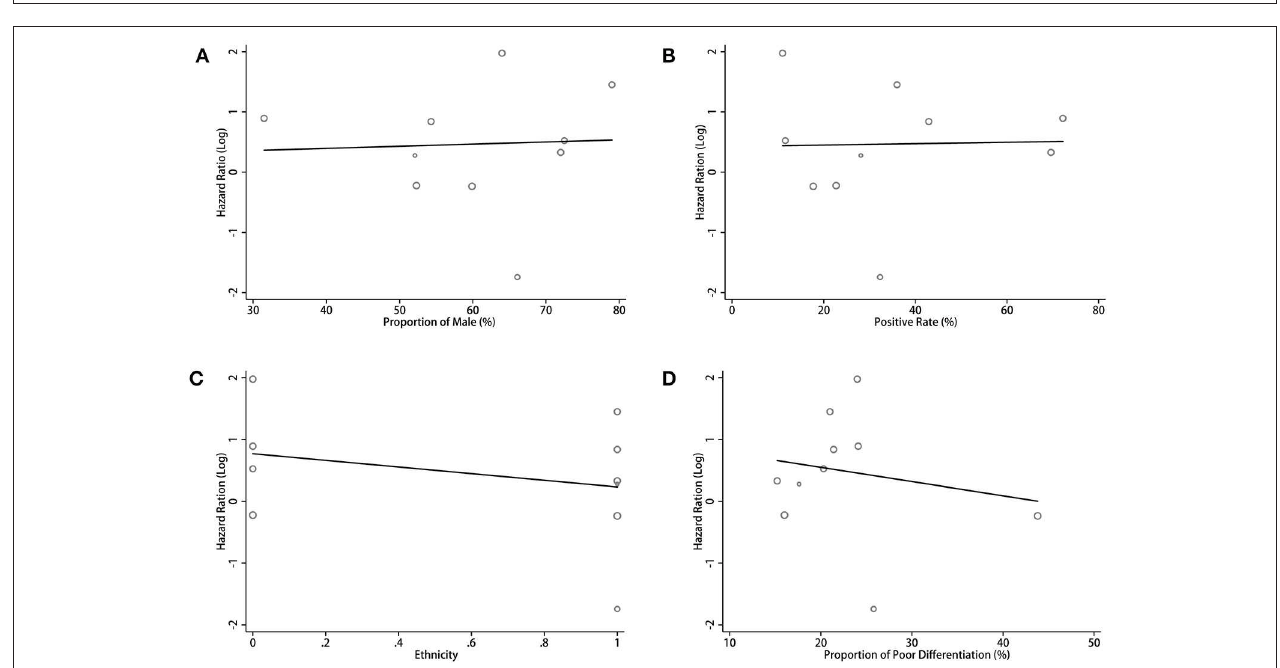
FIGURE 5 | Subgroup analyses of the association between PD-L1 expression in TCs and OS.